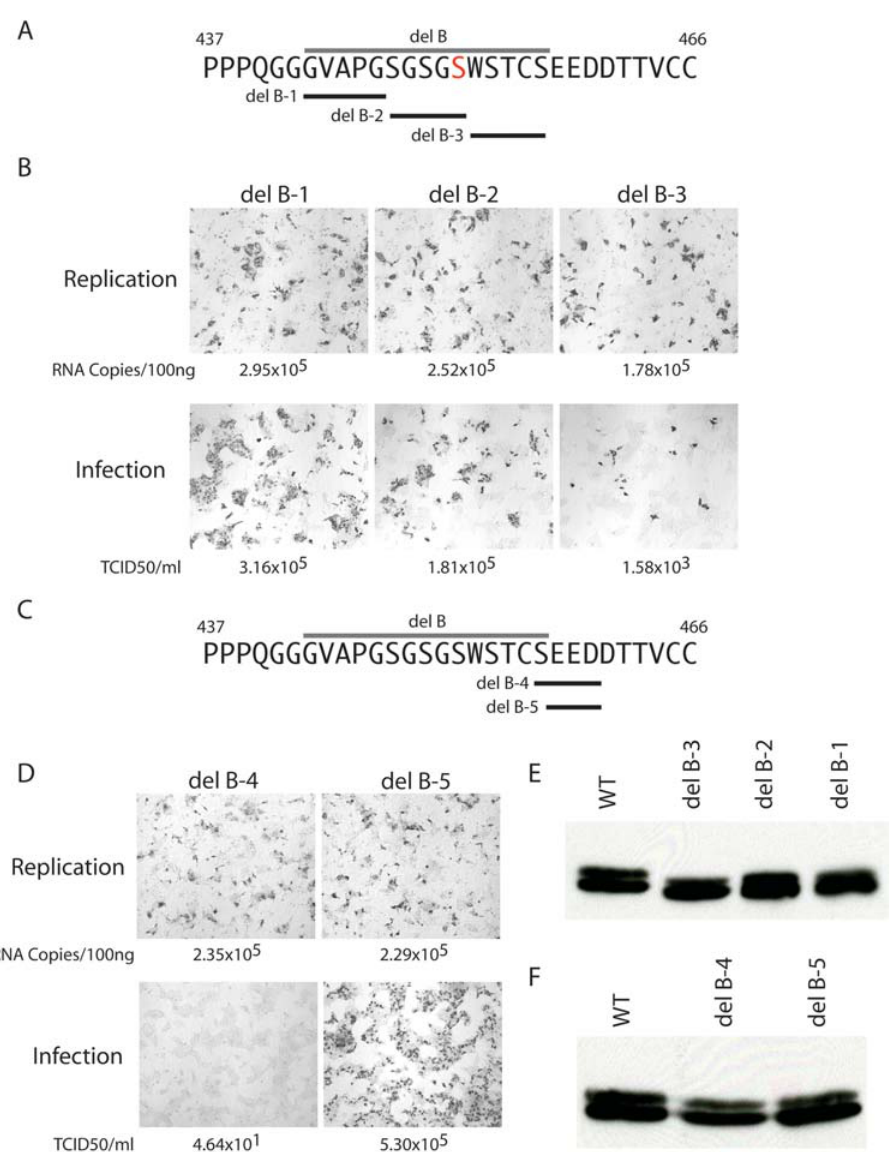
Figure 2. Mapping the disruption of infectious virus production. A). Sequence of JFH-1 NS5A around the region of deletion B (indicated by gray line). Deletions B-1, B-2 and B-3 are indicated by black bars. Numbers refer to amino acid numbering of the mature JFH-1 NS5A protein. Residue serine 452 is shown in red. B). IHC analysis of cells electroporated with indicated deletion bearing viral RNAs (top of image rows) for NS5A 48 hours post electroporation (top row of panels) or 48 hours post infection (bottom row of panels). Numbers beneath each panel are HCV RNA copies per 100 ng of total RNA (top row of images) and infectivity release from titering (bottom row of images). C). Sequence of JFH-1, as described in A, now showing the location of deletion B-4 and B-5 with black bars. D). IHC analysis of deletion B-4 and B-5. Panel layout is as described in B. Numbers below the images are as described in B. E). Western blot analysis of NS5A from cells electroporated with replication competent full-length viral genomes of wild-type (WT) and deletions B-1, B-2, and B-3 (del B1, del B2, and del B3) shown in panel B. F). Western blot analysis of NS5A from cells electroporated with replication competent full-length viral genomes as shown in panel D. Nomenclature is as described in E. doi:10.1371/journal.ppat.1000032.g002 release of infectious virus for these mutant RNAs by titering released virus in the supernatants by limiting dilution (Figure 3C).